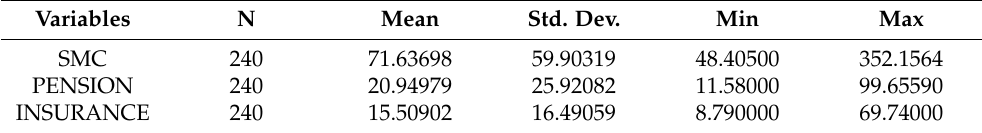
Table 1. Dataset